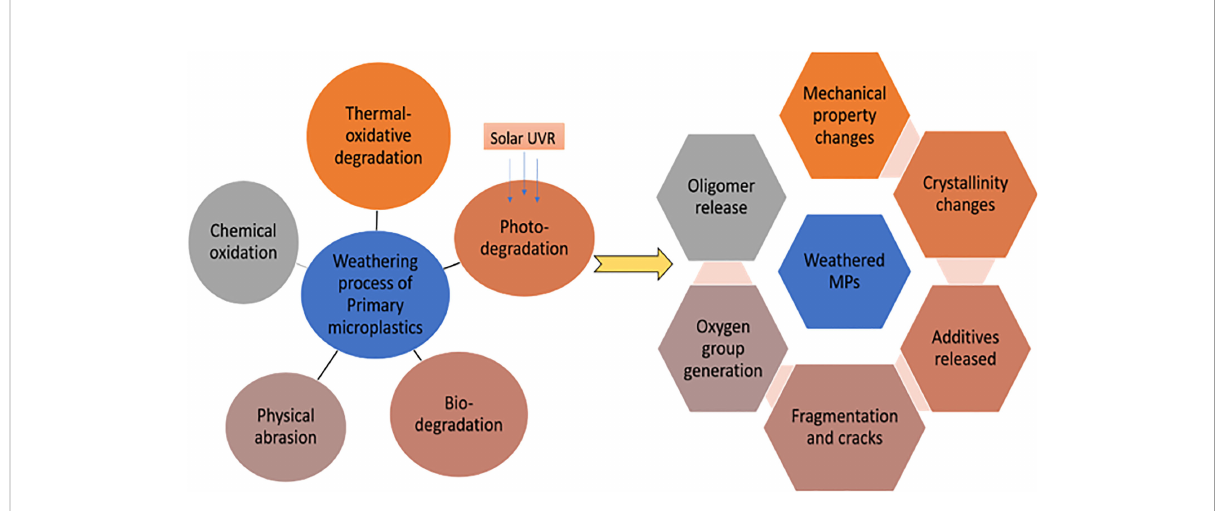
FIGURE 6 Diagram depicts weathering of primary MPs subjected to different weathering